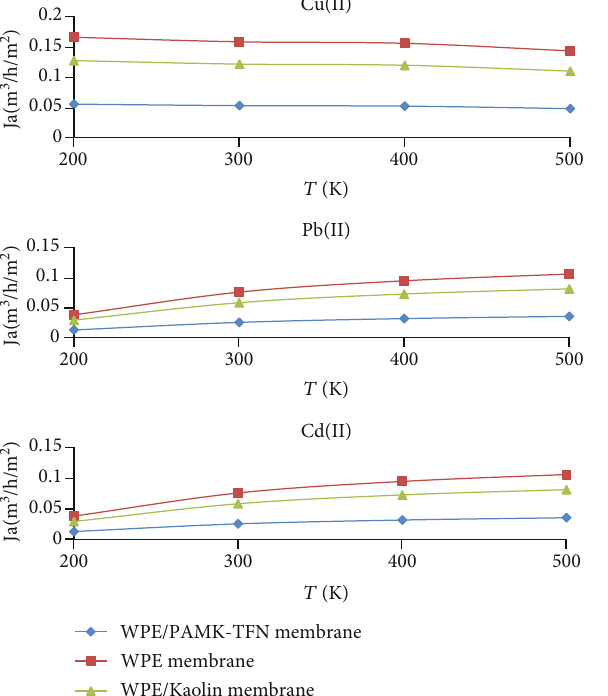
Figure 14: E ff ect of pH value on the fl ux of heavy metals on the prepared WPS, WPS/kaolin, and WPE/PAMK-TFN